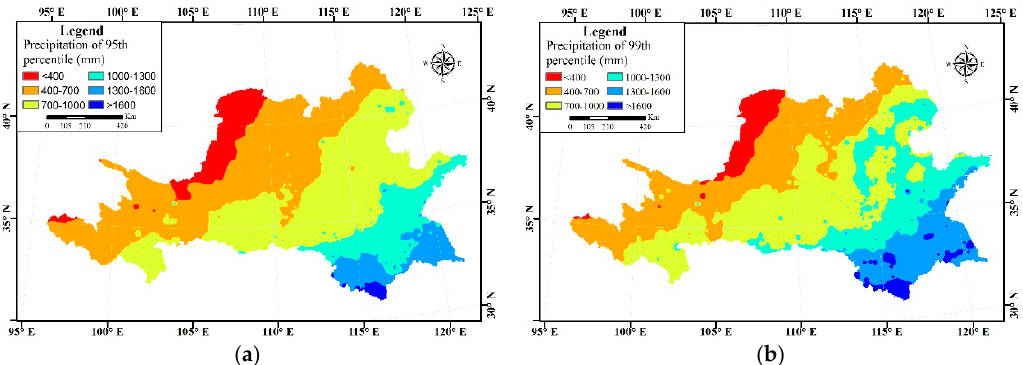
Figure 9. The 95th percentile and 99th percentile of the extreme precipitation threshold. ( a ) The 95th percentile; ( b ) the 99th percentile.